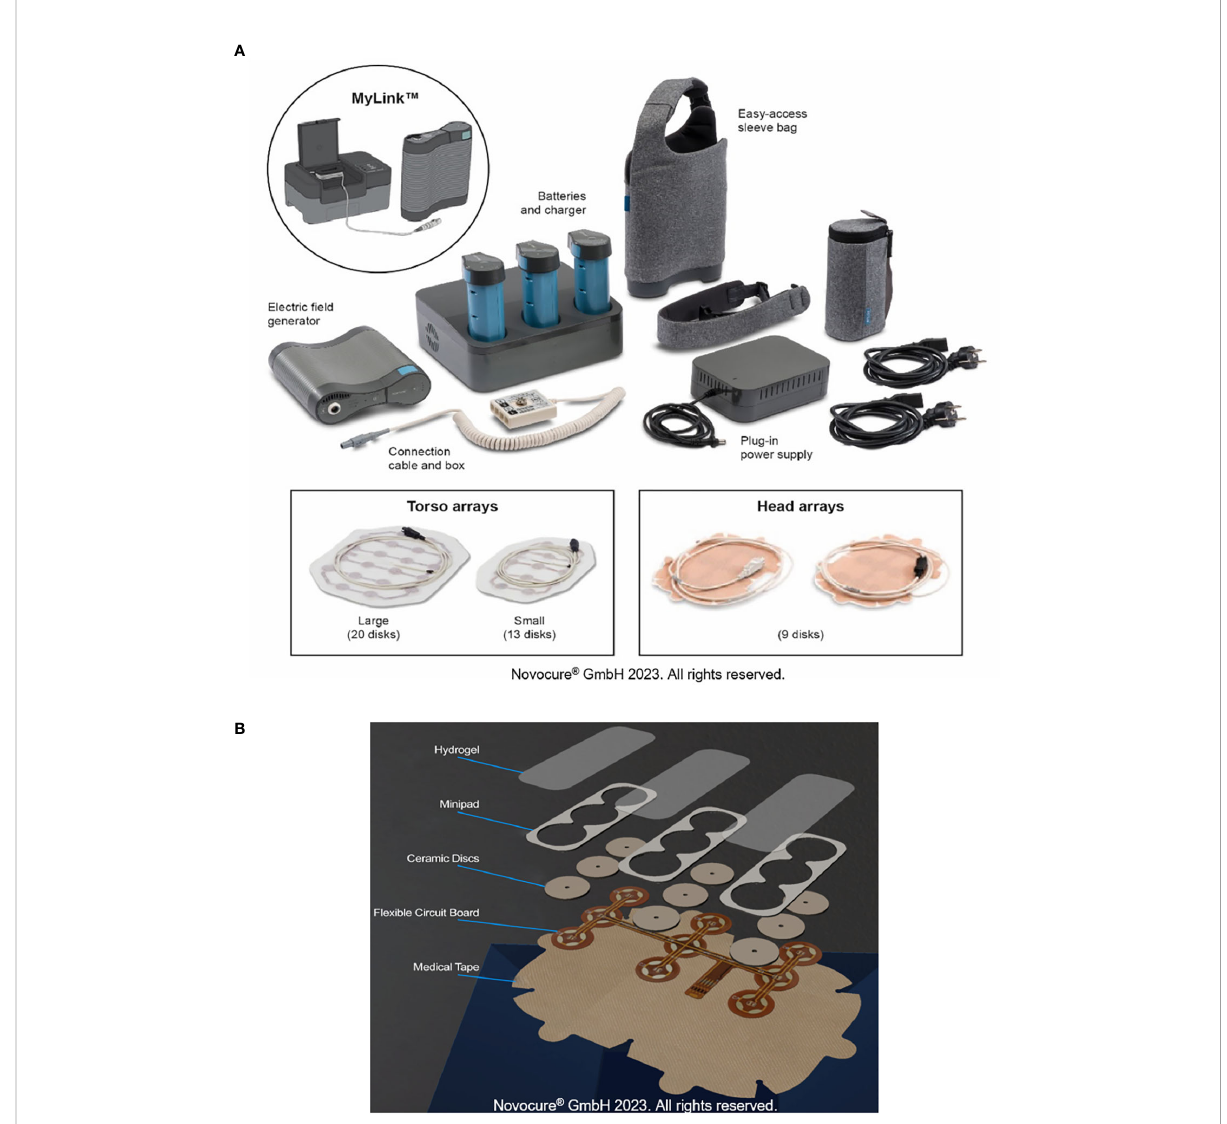
FIGURE 1 TTFields therapy device. All components of the portable medical device that generates TTFields (A) . Components of the arrays used to deliver TTFields therapy (B) . TTFields, Tumor Treating